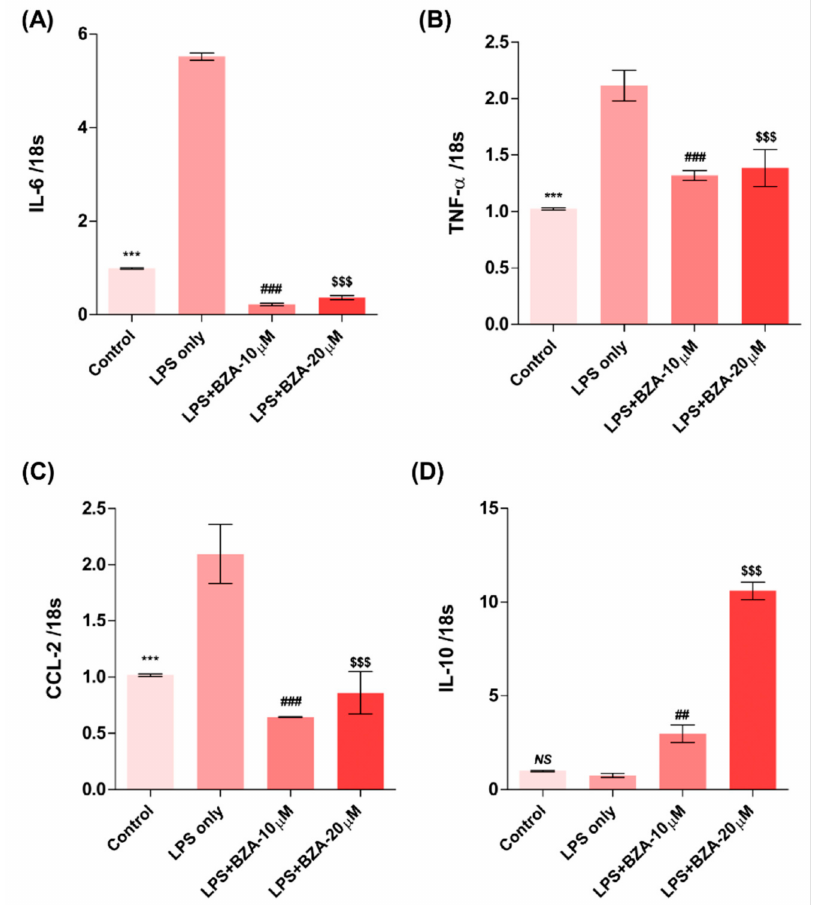
Figure 2. BZA promotes the resolution of inflammation in vitro. Total RNA was extracted from the LPS- and BZA (10 µ M and 20 µ M)-treated RAW 264.7 cells at 24 h following incubation ( n = 3, performed in triplicate). The mRNA levels of proinflammatory cytokines including IL-6 ( A ), TNF- α ( B ), and CCL2 ( C ) and an anti-inflammatory cytokine, IL-10 ( D ), were measured. For time, 18 s was used as internal control for qRT-PCR. Data represent mean ± SEM ( n = 3 ( A , C ), n = 4 ( D ), n = 6 ( B ); performed in triplicate). *** p < 0.001 (LPS-treated vs. control, DMSO), ## p < 0.01, ### p < 0.001 (LPS-treated vs. LPS + BZA 10 µ M), $$$ p < 0.001 (LPS-treated vs. LPS + BZA 20 µ M) , NS = Not significant, one-way ANOVA followed by the Bonferroni